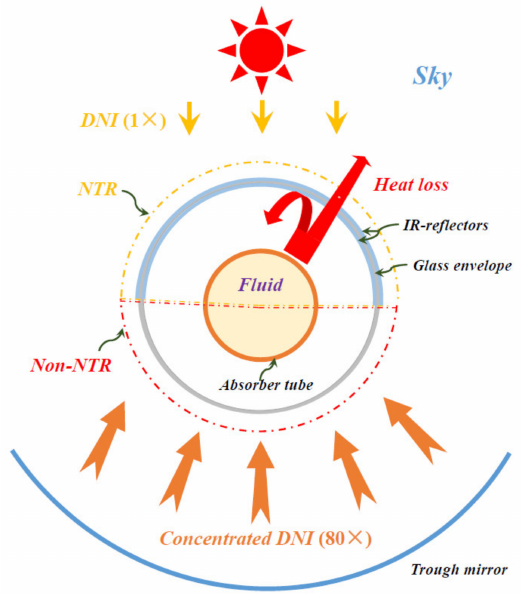
Figure 1. Schematic diagram of novel heat collecting elements (HCEs) with infrared (IR)-reflectors on the glass envelope in the negative thermal-flux